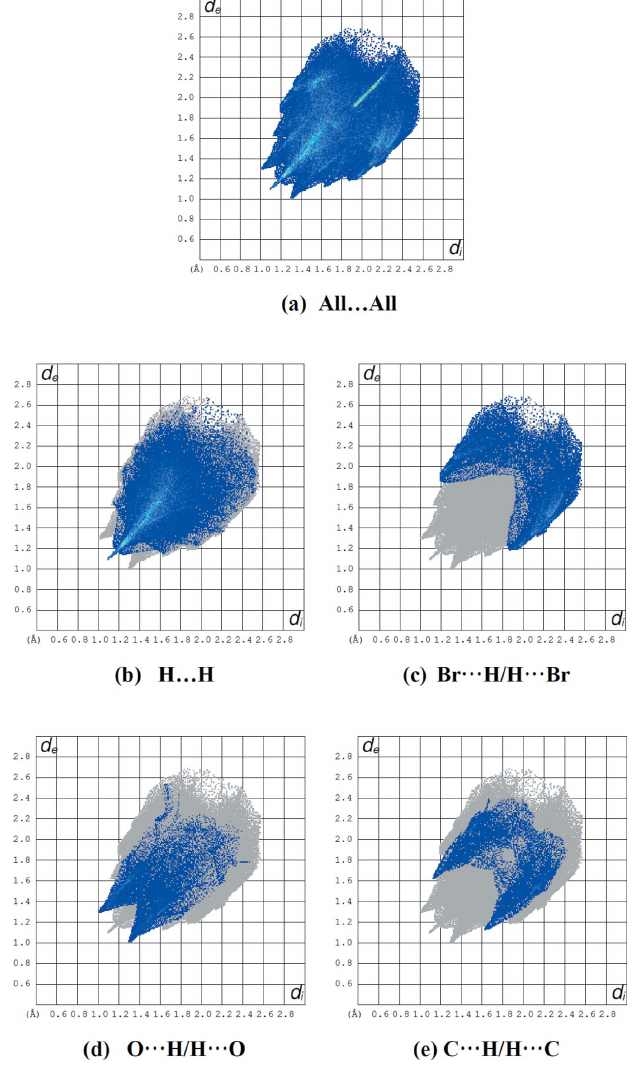
Figure 7 A view of the two-dimensional fingerprint plots for the title compound, showing ( a ) all interactions, and delineated into ( b ) H (cid:2)(cid:2)(cid:2) H, ( c ) Br (cid:2)(cid:2)(cid:2) H/ H (cid:2)(cid:2)(cid:2) Br, ( d ) O (cid:2)(cid:2)(cid:2) H/H (cid:2)(cid:2)(cid:2) O and ( e ) C (cid:2)(cid:2)(cid:2) H/H (cid:2)(cid:2)(cid:2) C interactions. The d i and d e values are the closest internal and external distances (in A˚ ) from given points on the Hirshfeld